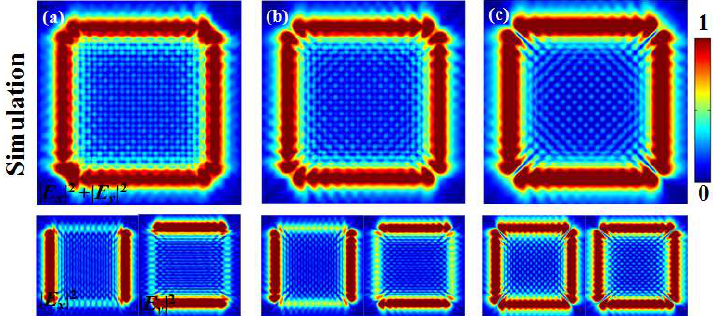
Figure 6. ( a – c ) are the corresponding simulation results with finite-difference time-domain (FDTD).